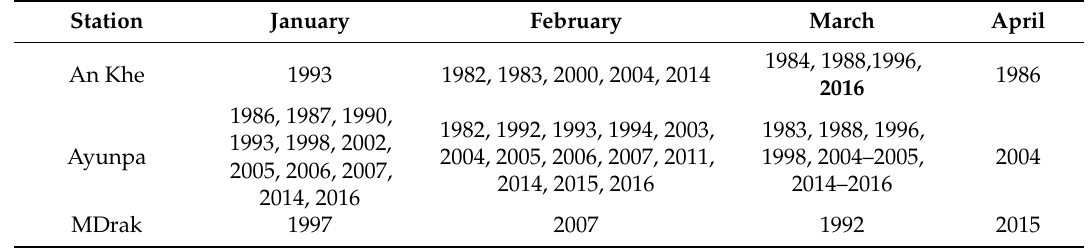
Table 6. Statistics of the years of extreme drought in the period 1981–2016, with index J ≤ 5.